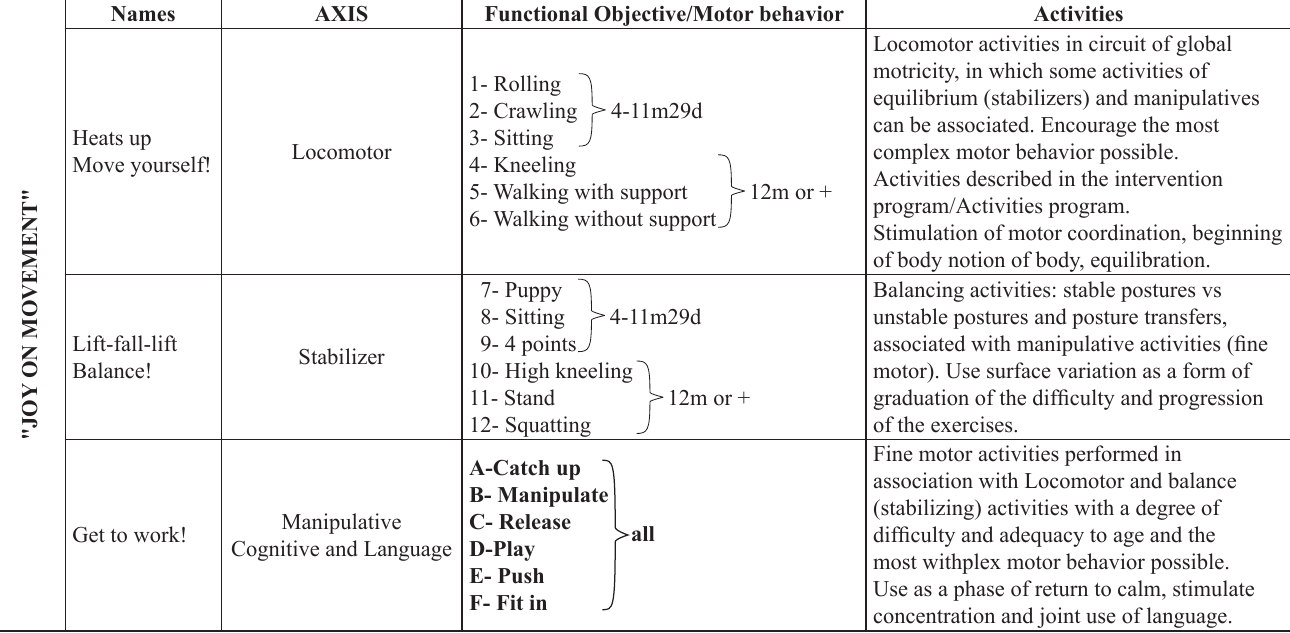
Table 1. Early Intervention Program (EIP) based on motor milestones